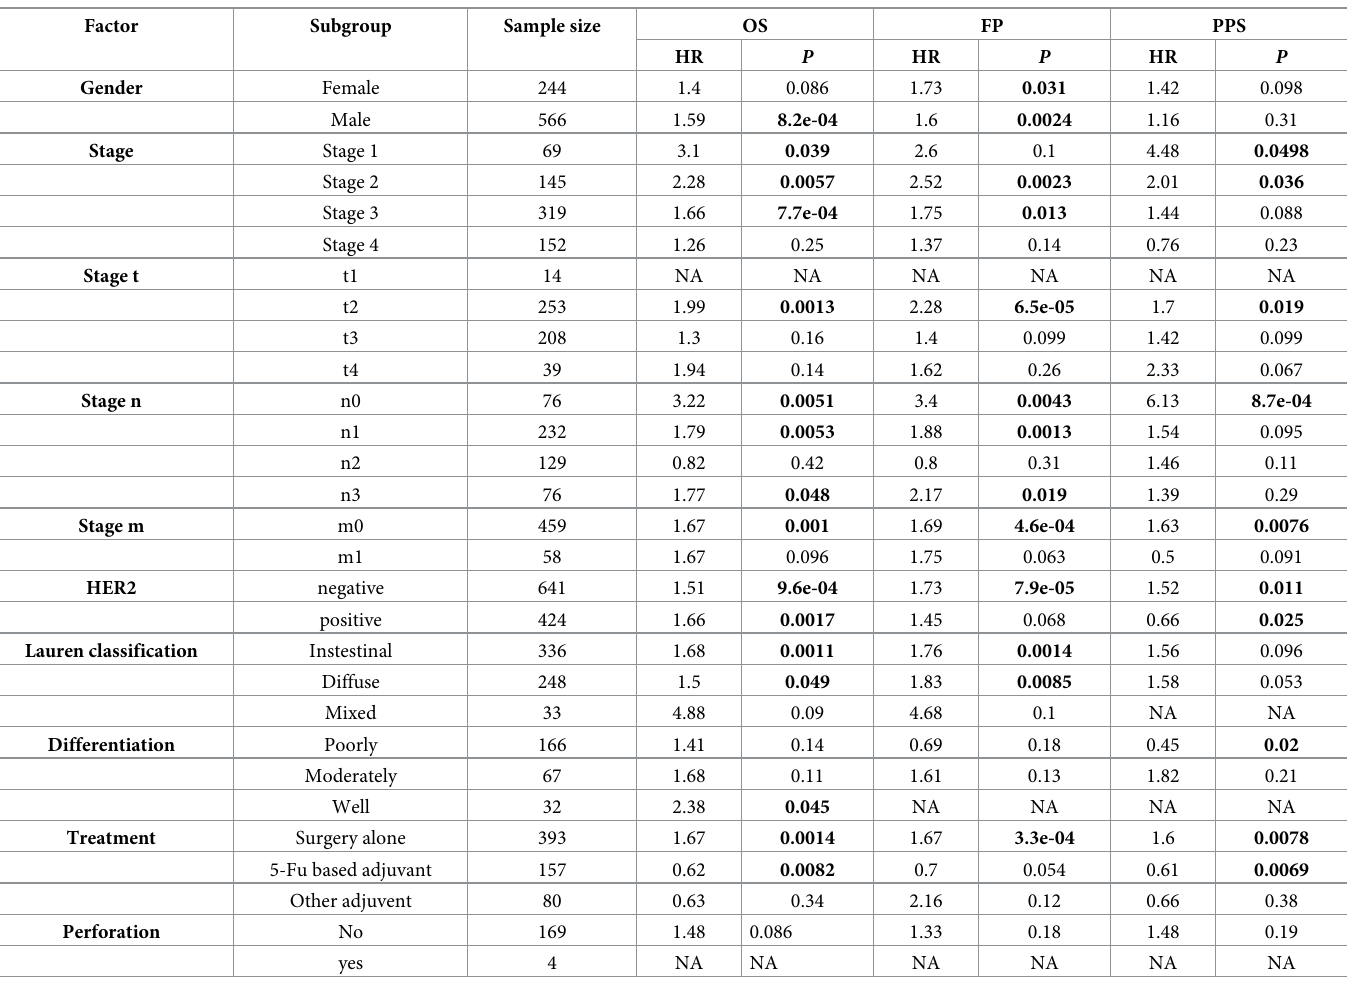
Table 4. Subgroup analysis on the correlation of SMARCA1 expression and prognosis of gastric cancer cases. Factor Gender Stage